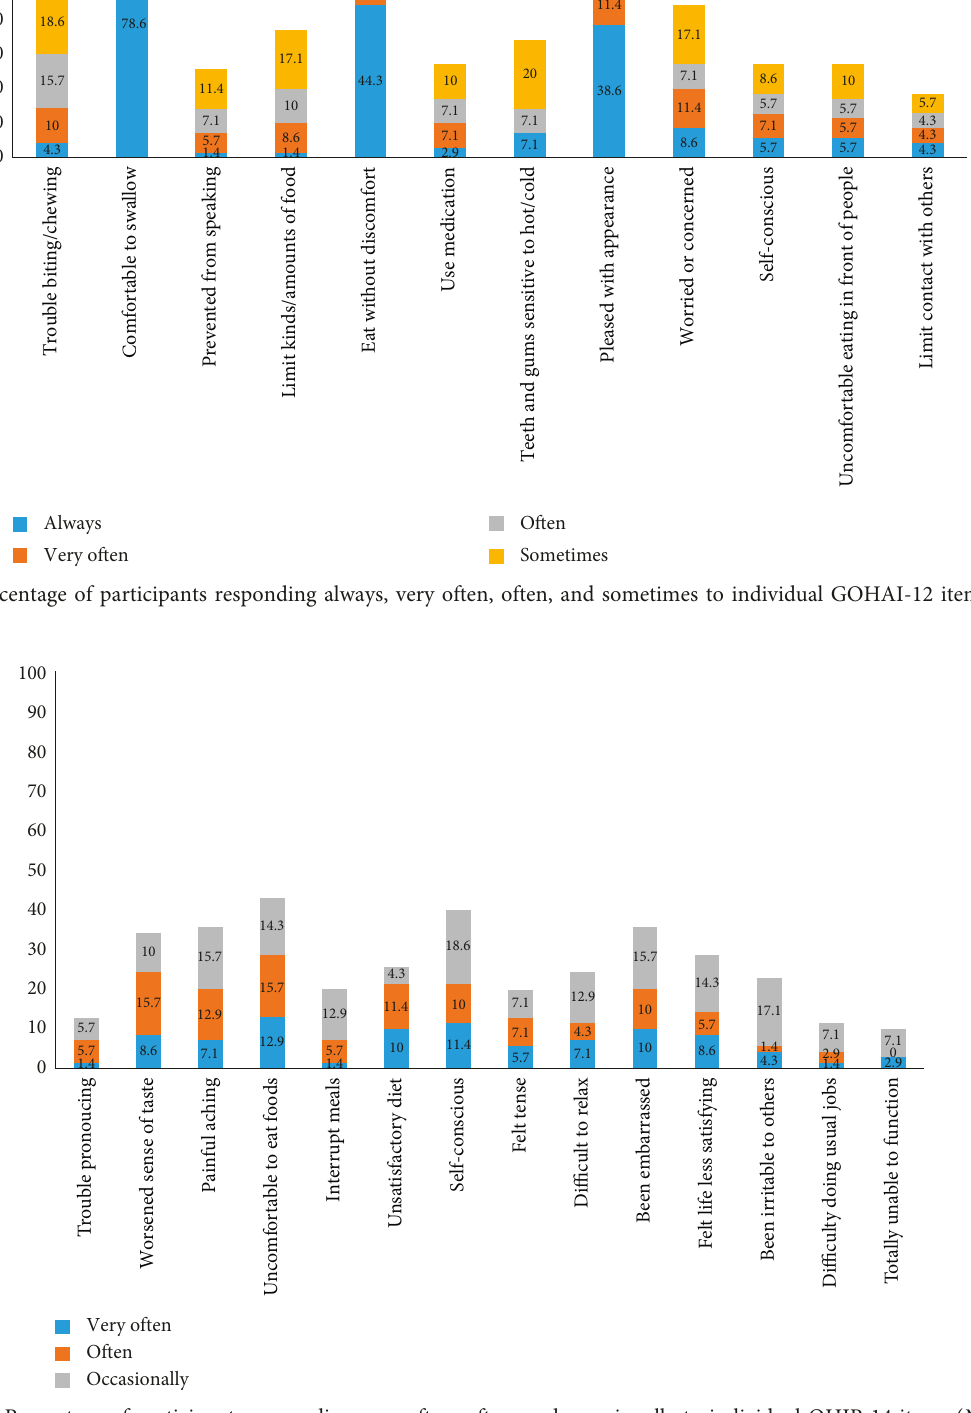
Figure 2: Percentage of participants responding very often, often, and occasionally to individual OHIP-14 items ( N �